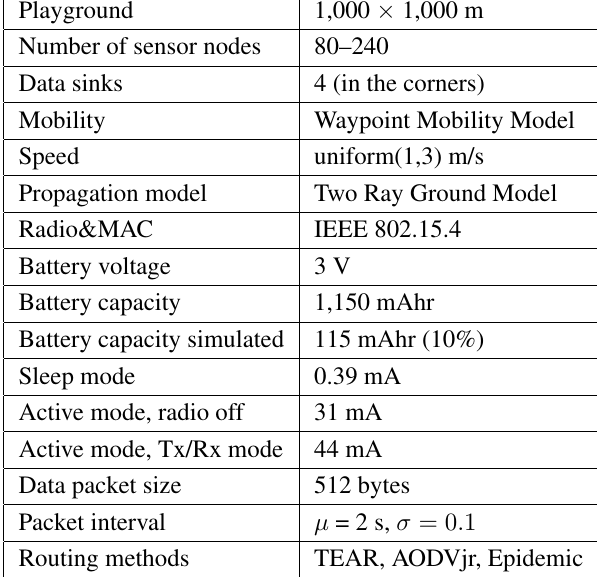
Table 1. Simulation